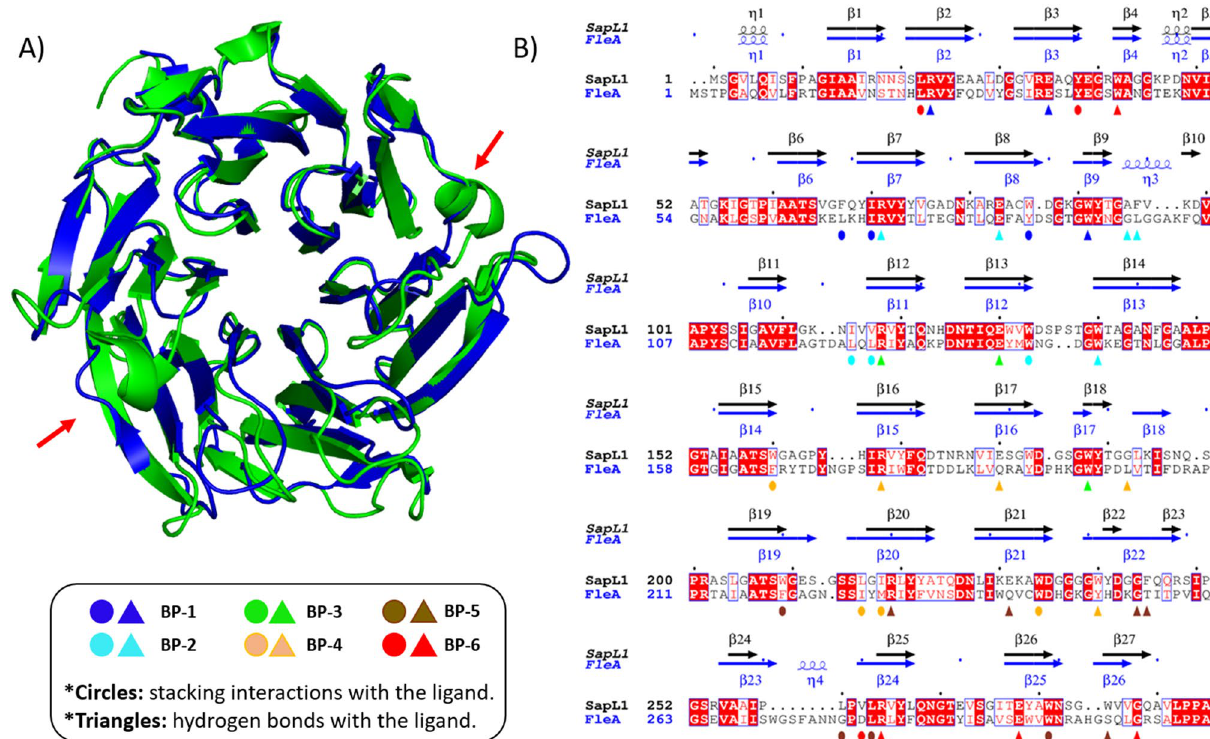
Figure 5. SapL1/FleA comparison. ( A ) Overlay of SapL1 (blue, PDB: 6TRV) and FleA (green, PDB: 4D4U) structures. Red arrows indicate the main differences between structures. ( B ) Sequence alignment of SapL1 and FleA with display of their secondary structure elements. The residues involved in ligand interactions of each pocket are indicated by circles for hydrophobic and stacking interactions and by triangles for hydrogen bonds colored according to the binding pocket: BP-1, blue; BP-2 cyan; BP-3 green; BP-4, orange, BP-5, brown; BP-6,